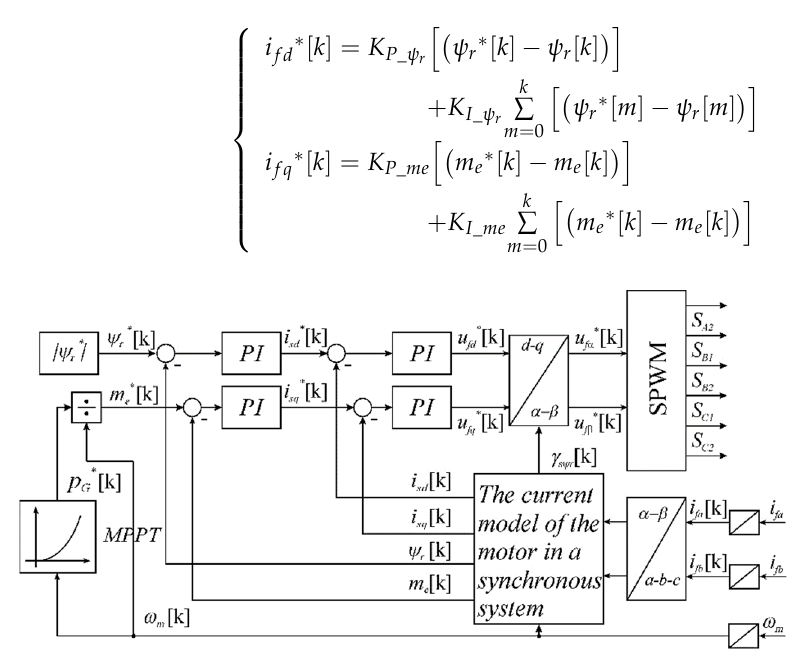
Figure 5. Block diagram of the induction generator control algorithm.